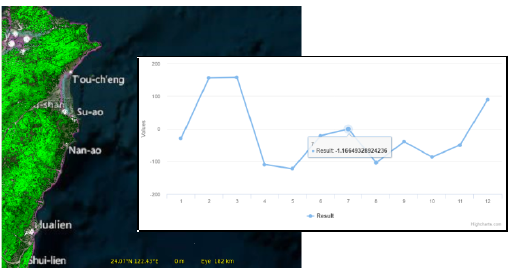
Figure 4. FCU/CODE-DE federation query path: query sent to FCU from Singapore, subquery generated for